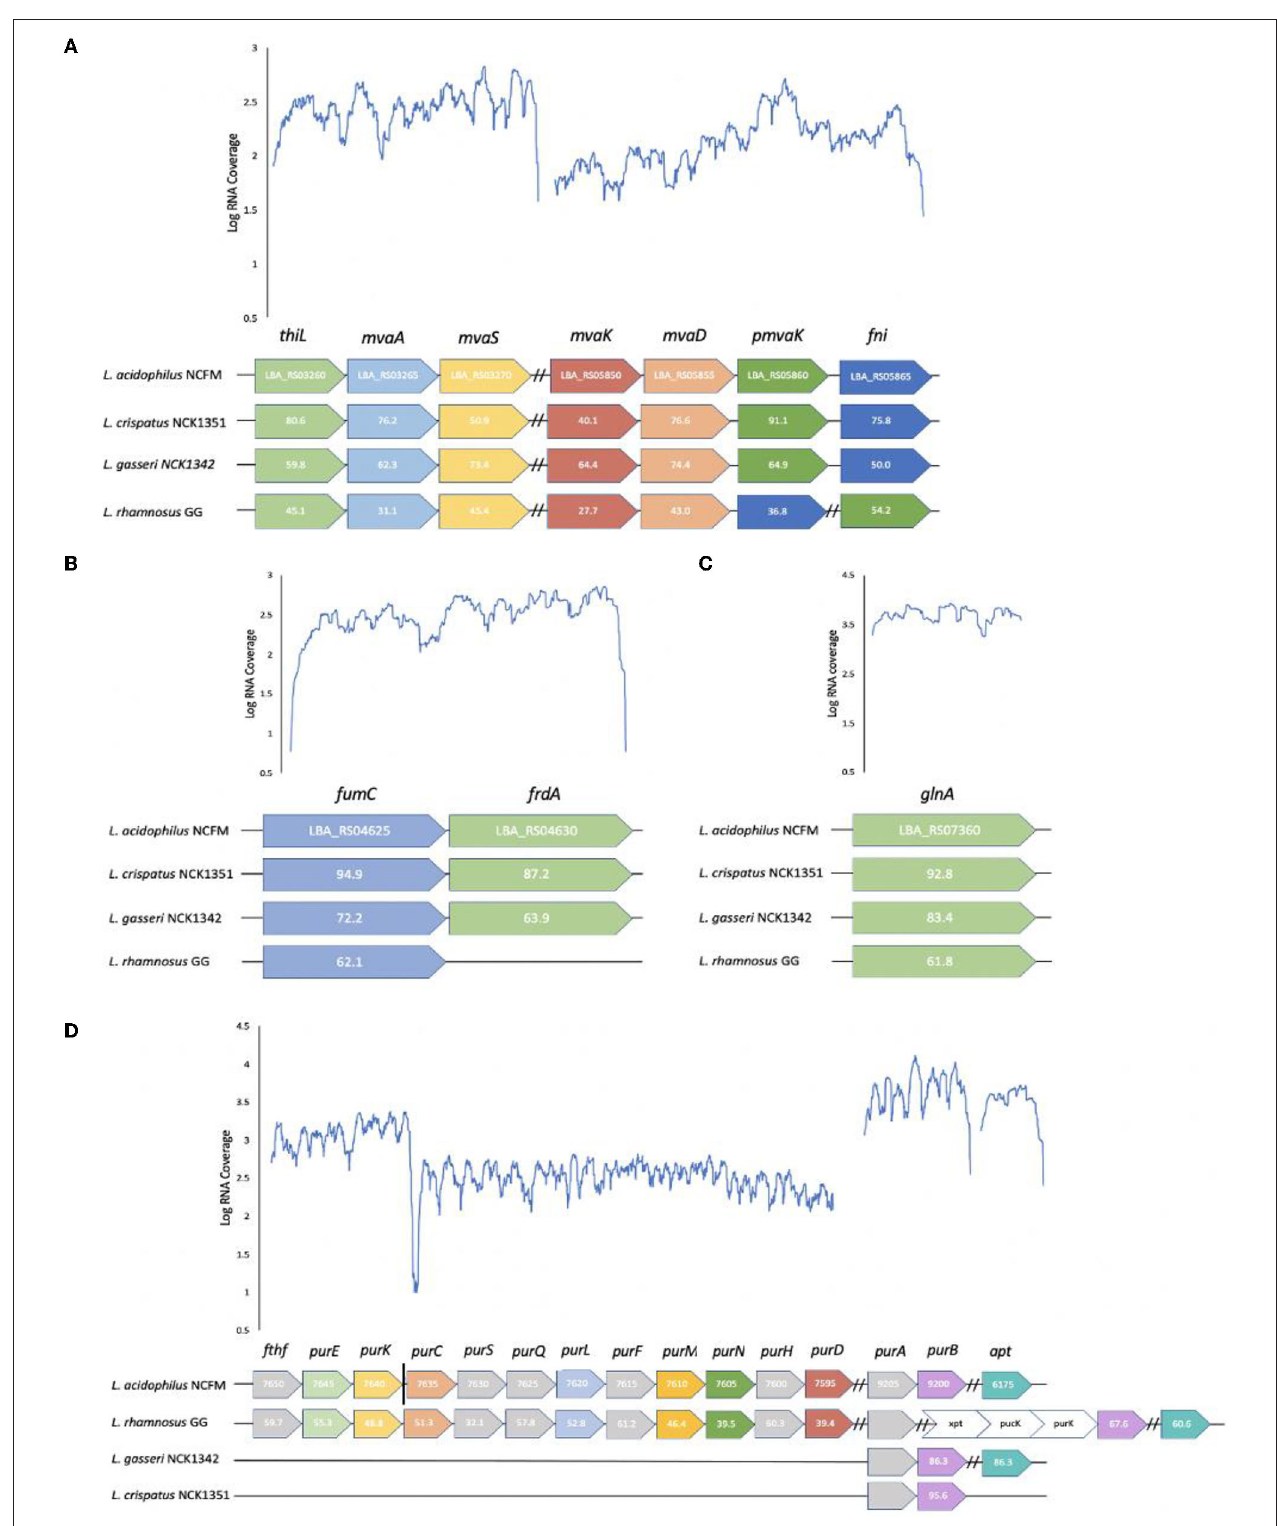
FIGURE 6 | Loci comparison across strains and transcriptional profiles of L. acidophilus NCFM for defined loci in metabolite pathways. Conserved loci and amino acid sequence identities relative to L. acidophilus NCFM are shown in select Lactobacillus strains for (A) mevalonate (B) fumarate (C) glutamine, and (D) 5-aminoimidazole-4-carboxamide. The gray and white arrows represent genes that are not required in the specific metabolic pathway but are located within the operon. The vertical solid black line distinguishes between operons but loci are adjacent to one another on the chromosome. Dashed black lines distinguish between operons on separate parts of the